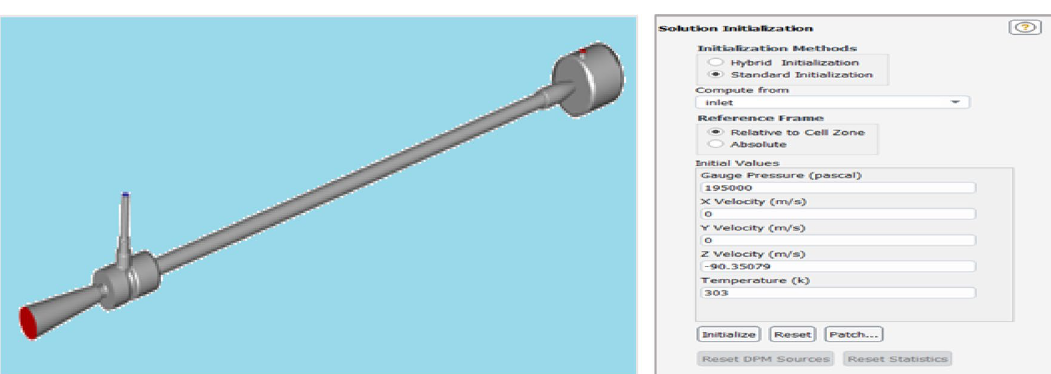
Figure 62. Initialization from the inlet of the vortex tube.